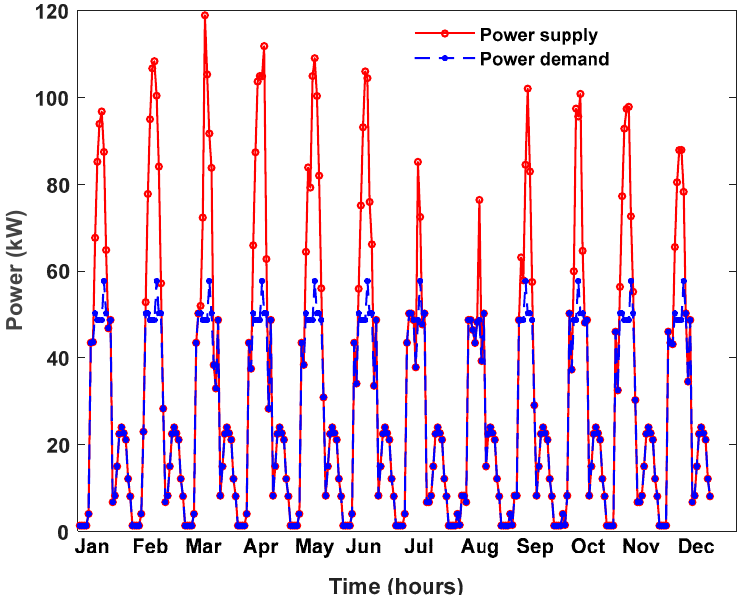
Figure 13. The comparison between the total power supply and the total power demand at any time of the year.